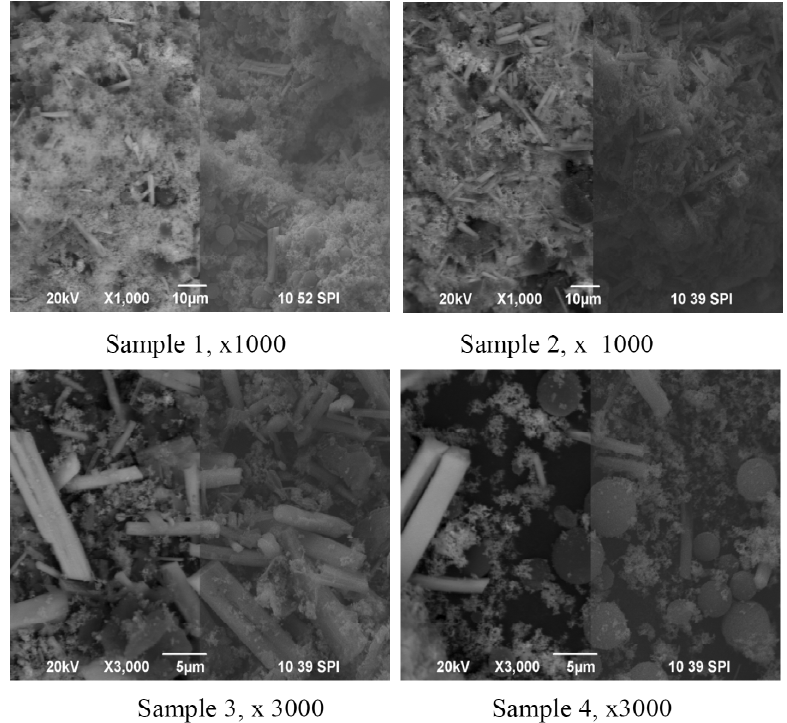
Fig. 1. SEM images of the samples synthesized at a ratio Co:Sn=35:65: Sample 1-Co-Sn nanoparticles, Sample 2-Co-Sn nanoparticles/CF, Sample 3-Co-Sn nanoparticles/CF and  -CDx, Sample 4-Co-Sn